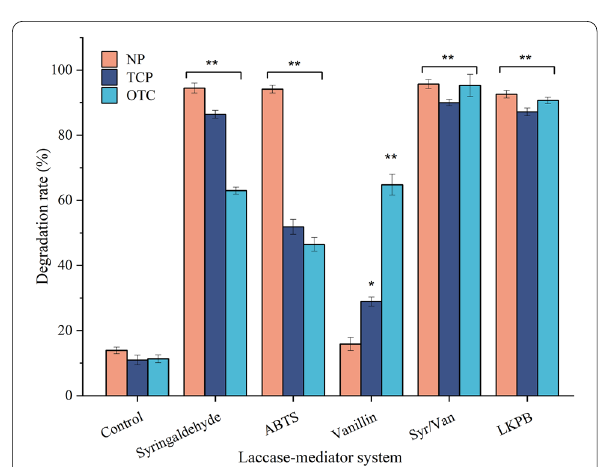
Fig. 5 Degradation of POPs by different laccase–mediator systems. Individual POP on 50 mg/L was treated with 0.2 IU/mL laccase at pH 4.0, 50 ℃ for 4 h in the presence or absence of 0.3 mM individual mediator or Syr/Van complex with a ratio of 4:6. Control was performed on 50 mg/L individual POP with 0.2 IU/mL laccase without mediators. Residual POP concentrations were determined by HPLC. Error bars represent the standard deviation of three independent repeats. * p < 0.05, ** p < 0.01 compared with